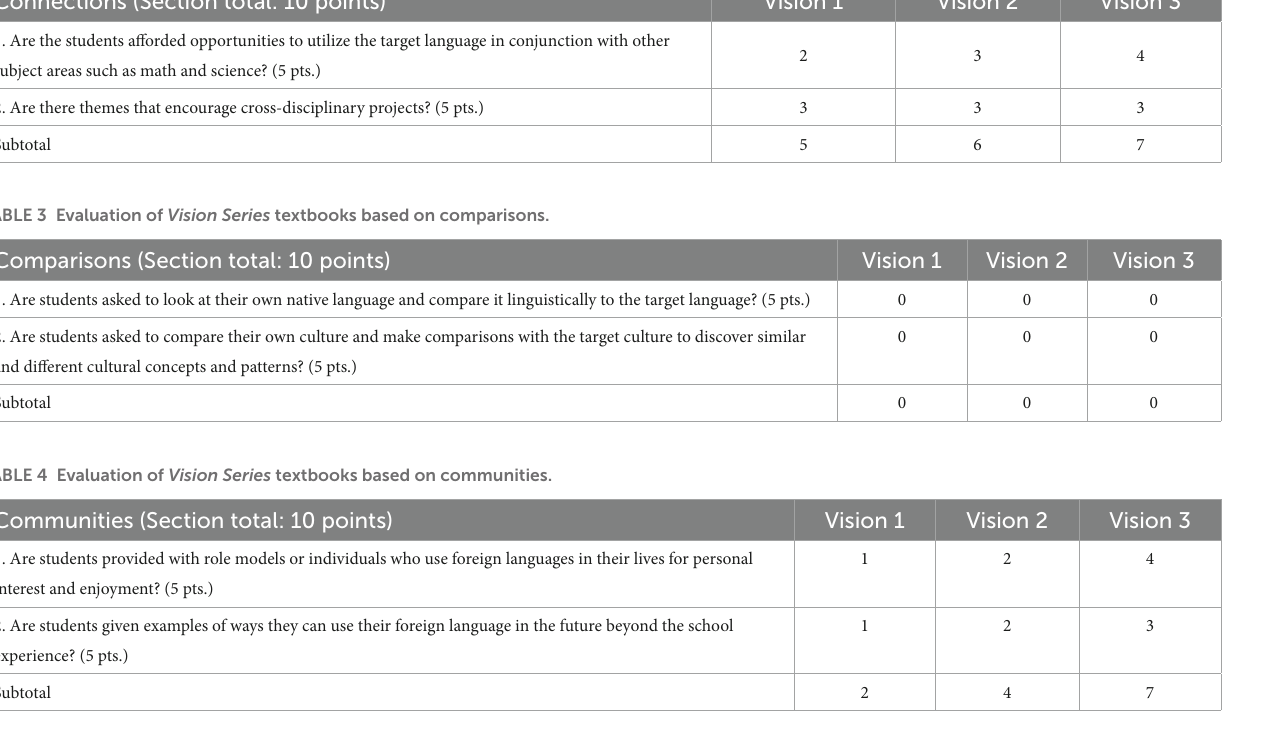
TABLE 2 Evaluation of Vision Series textbooks based on connections. Connections (Section total: 10 points)